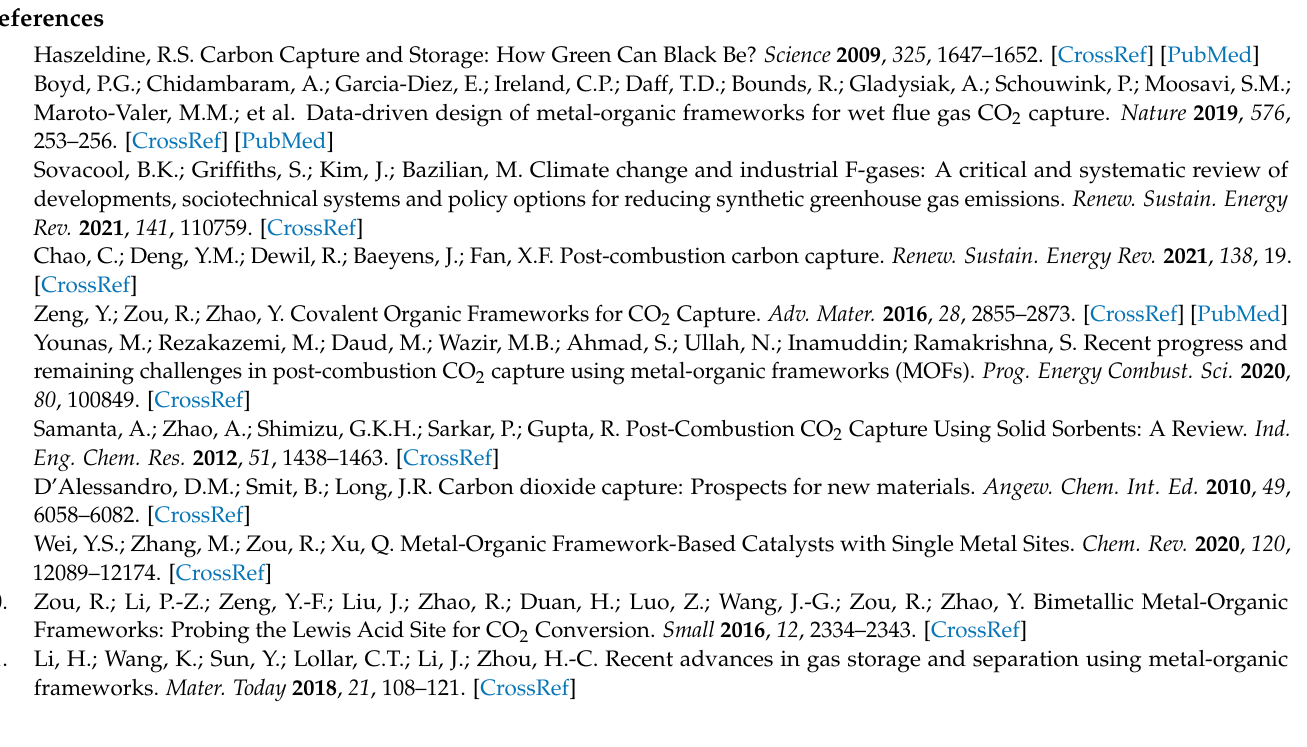
10.3390/nano11123348/s1, Figure S1: PXRD patterns of MIP-207 and MIP-207 after activation at 150 ◦ C. Figure S2: PXRD pattern of MIP-207-NH 2 -100%. Figure S3: SEM images of ( a , b ) MIP-207, Figure S4: The pore size distribution curves of MIP-207. Figure S5: N 2 adsorption and desorption isotherms of MIP-207-NH 2 -100%. Figure S6: The relationship of between CO 2 /N 2 adsorption and specific surface area of samples. Table S1: The BET data of MIP-207-NH 2